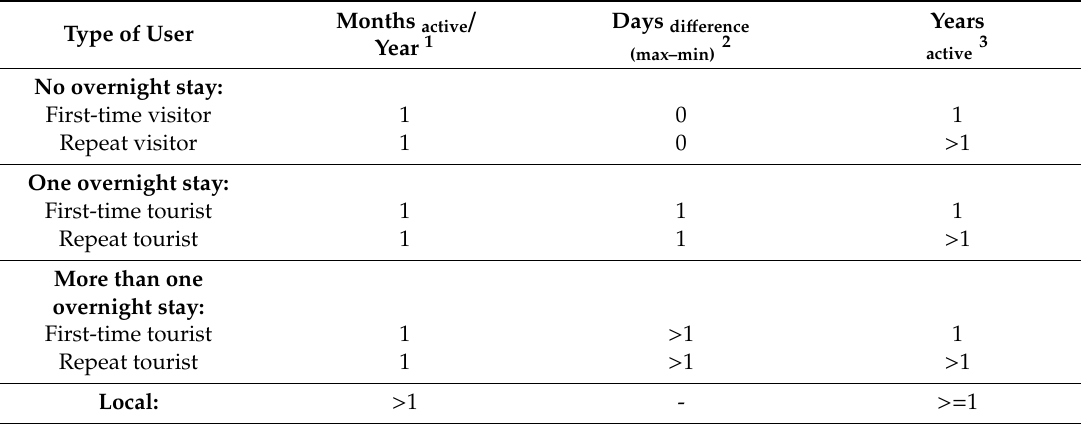
Figure 3. Diagram flow of steps implemented to clean the data collected from Flickr. Source: Authors’ own elaboration. Table 1. Criteria of Flickr users’